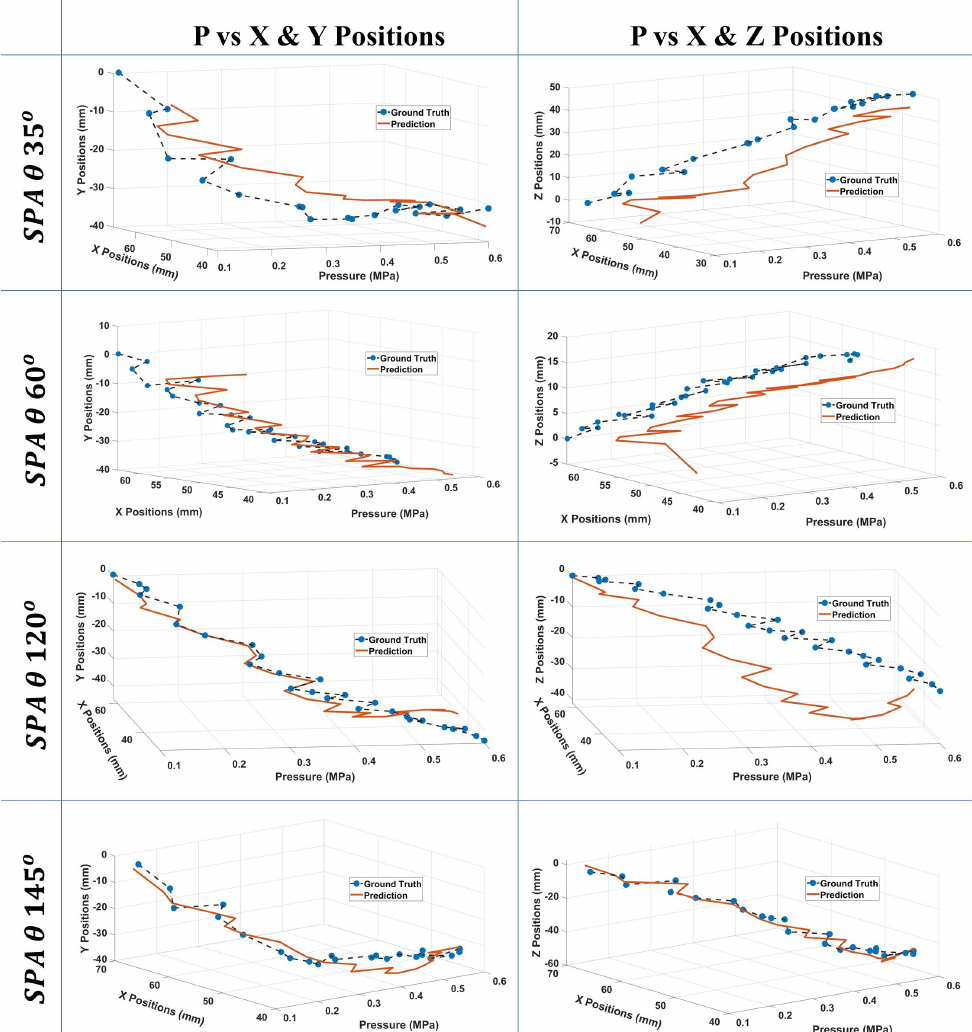
Figure 5. Prediction results of the ESN network after optimizing the 8 hyperparameters. 4 test samples, one from each θ angle, are plotted. The plots show the network’s predictions for the SPA tip’s motion plotted against the input